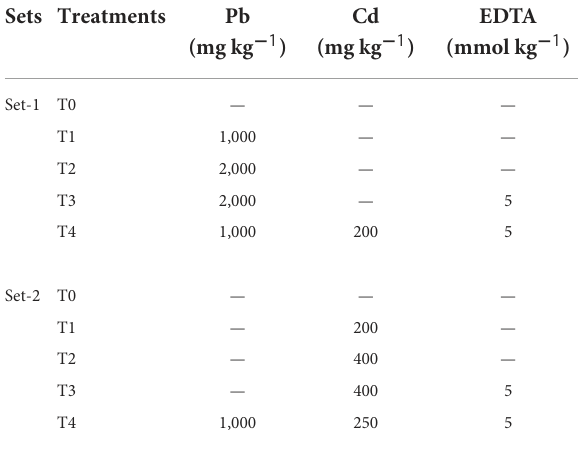
application of treatments. Their visuals attributes are given in Figure 1. Each plant sample was measured in terms of its height (cm), shoot length (cm), and root length (cm) with the help of a meter rod. Using digital balance, root and shoot fresh weights were measured in grams and the data were recorded. For dry weights, firstly, samples of shoots and roots have been dried for three days at 72 ◦ C in an oven. The dry weights of these samples were measured. Similarly, the total number of leaves in each pot was measured and the leaf area in each pot was measured following below formula: Leaf area = (Length × Width / Total no. of